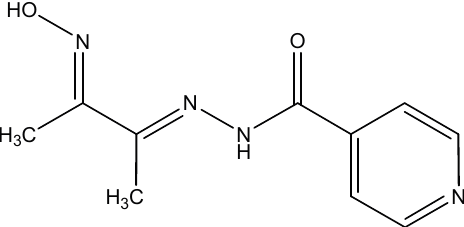
Figure 23. Structure of diacetyl monoxime isonicotinoyl hydrazone